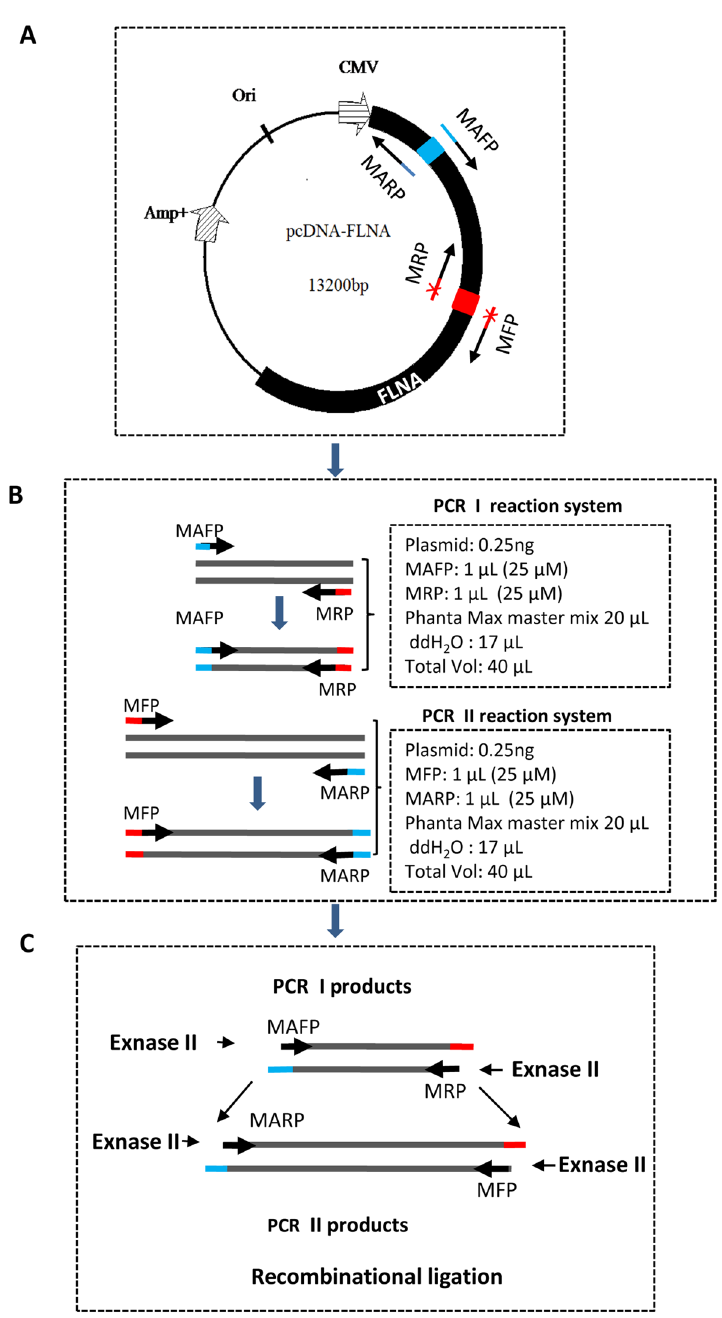
Figure 2. Establishment of the method for site-directed mutagenesis of large plasmids (SMLP) based on PCR. ( A ) A plasmid map showing the locations of the PCR primers designed. The pcDNA-FLNA plasmid is presented in the diagram, and two pairs of PCR primers are designed as indicated. MFP represents a mutation forward primer; MRP represents a mutation reverse primer; MAFP is a mutation-assisting forward primer; MARP is a mutation-assisting reverse primer. The blue or red colours represent partially complementary (overlap) regions between two primers. ( B ) A diagram showing two independent PCR reactions, PCR I and PCR II. PCR I is performed using the primer pair of MAFP and MPR; whereas PCR II is performed using the primer pair of MFP and MARP. The PCR I and II reaction systems were presented on the right of the panel. ( C ) A diagram showing the recombinational ligation of the products from the PCR I and PCR II under the Exnase II. The short black arrows represent the places digested by Exnase II; the long black arrows show how two DNA fragments are